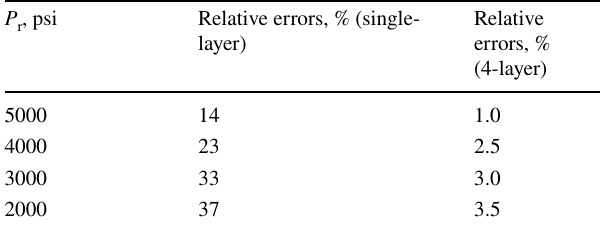
Fig. 5 Comparison of a single-layer and b 4-layer reservoir model with the actual 28-layer model Table 8 Relative errors of single-layer and 4-layer reservoir model in predicting production rate